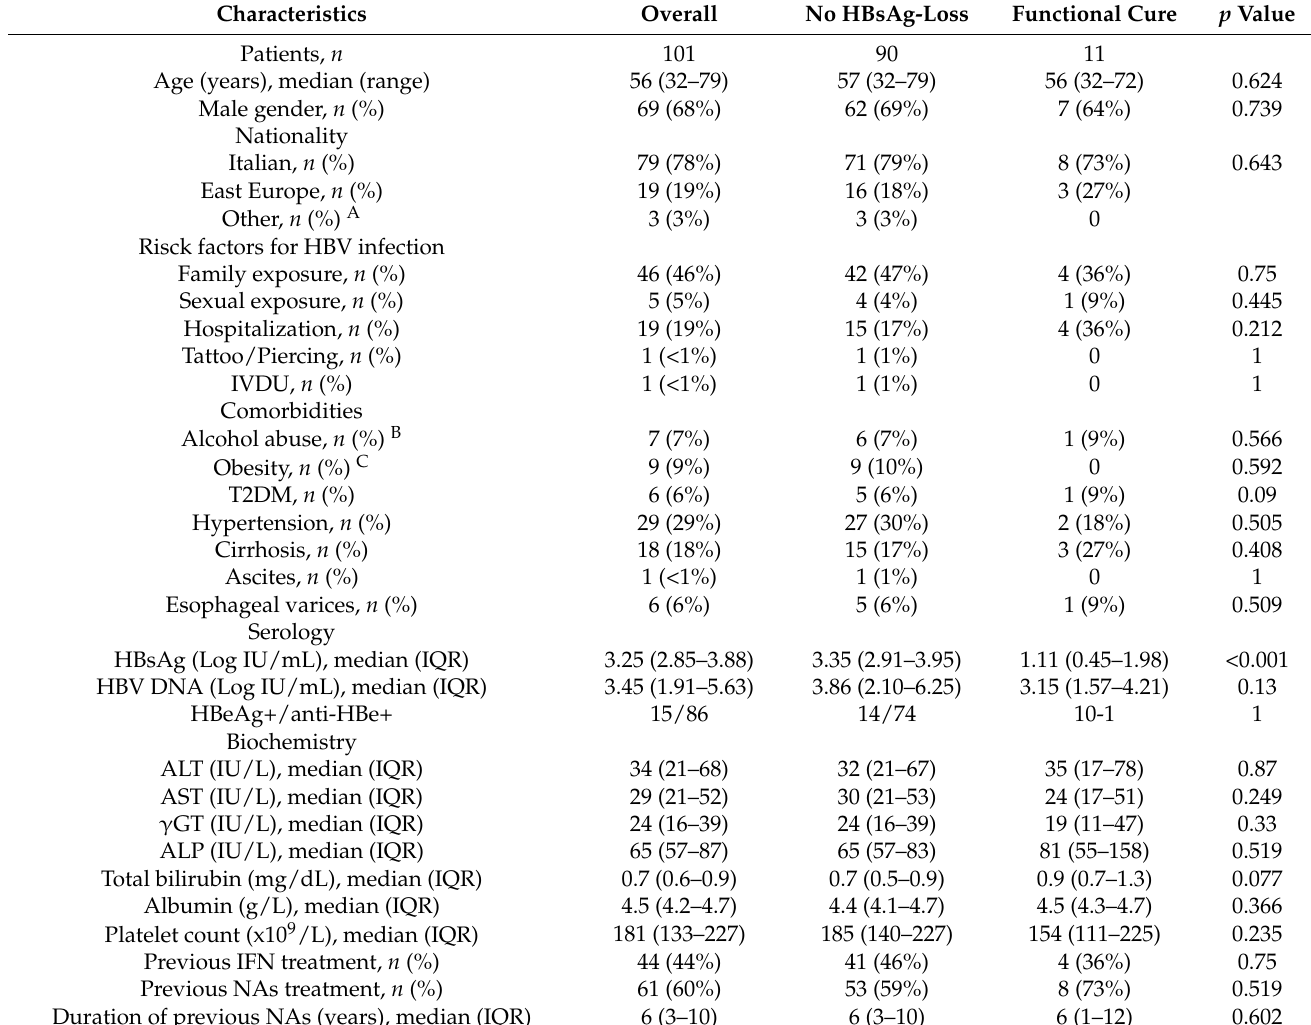
Table 1. Baseline characteristics of the overall cohort of patients included in the study and according to HBsAg